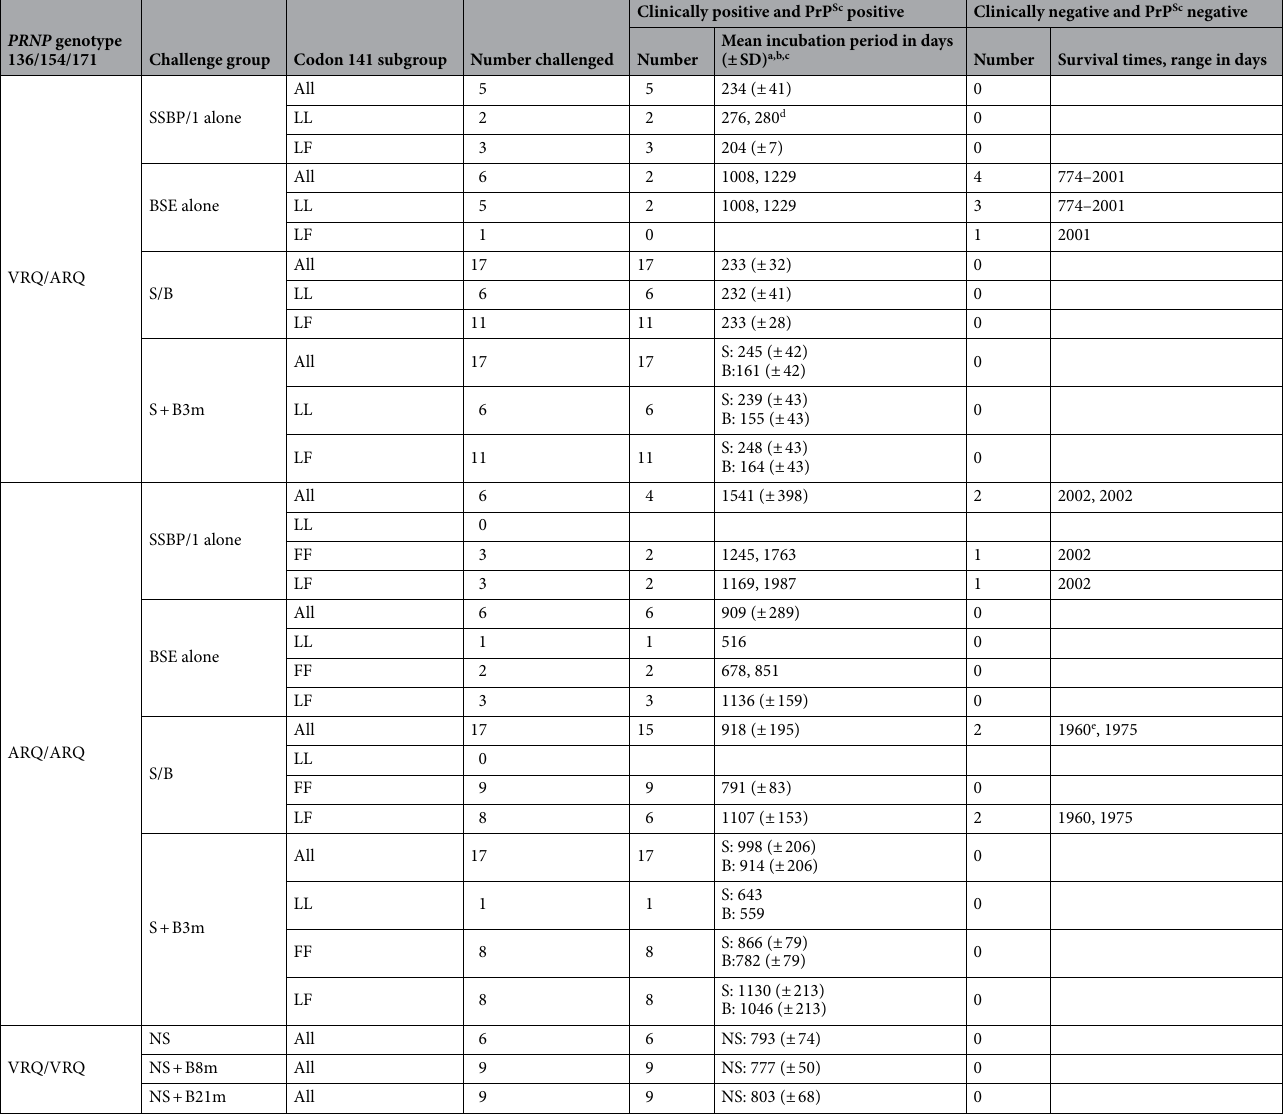
Table 1. Incubation periods of TSE inoculated sheep. a S: time between scrapie inoculation and culling. b B: time between BSE inoculation and culling. c NS: time between birth (assumed exposure to scrapie) and culling. d This animal had the P168L polymorphisms associated with longer incubation times for BSE. e This animal had the M112T polymorphisms associated with longer incubation times for